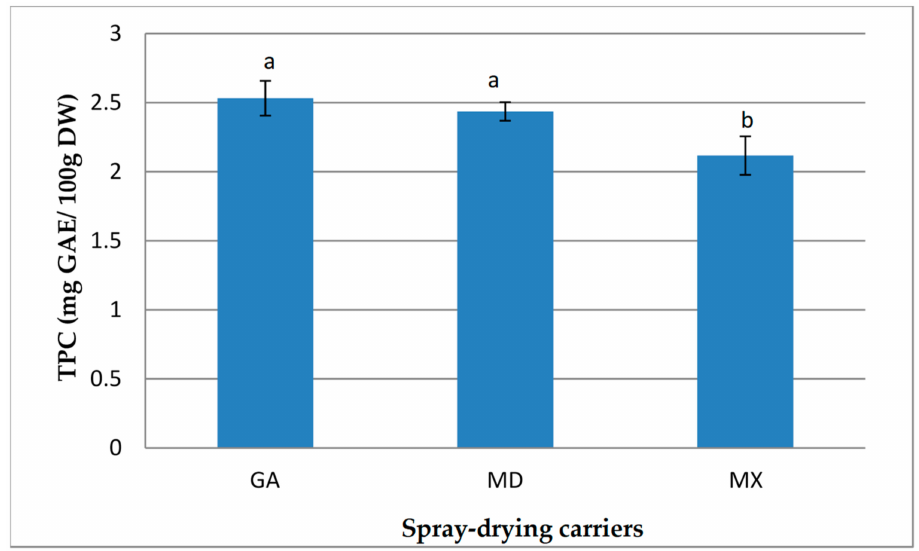
Figure 10. TPC of lemongrass leaf extract powders using different spray-dying carriers. All data are the mean ± SD. Values with different letters are significantly different ( p < 0.05).